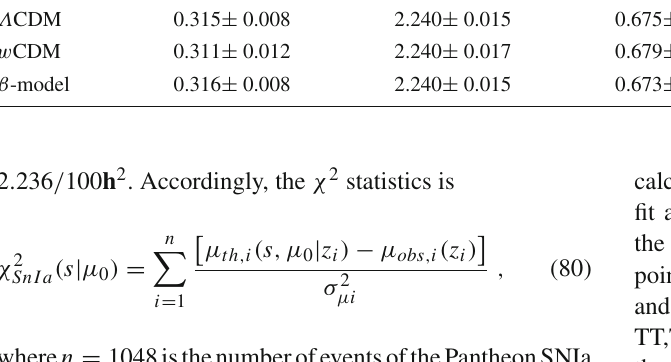
Table 3 A summary of the mean values of the main cosmological parameters calculated by using MCMC chains of each model.